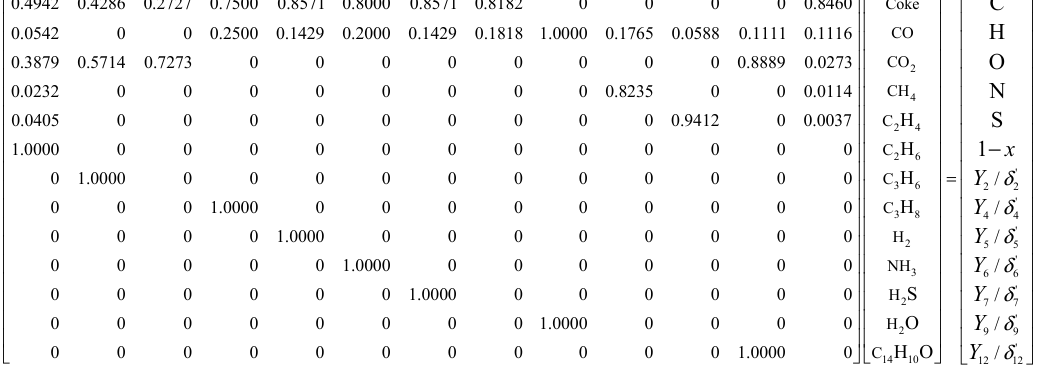
Table 4. Comparison between simulation and industrial data.